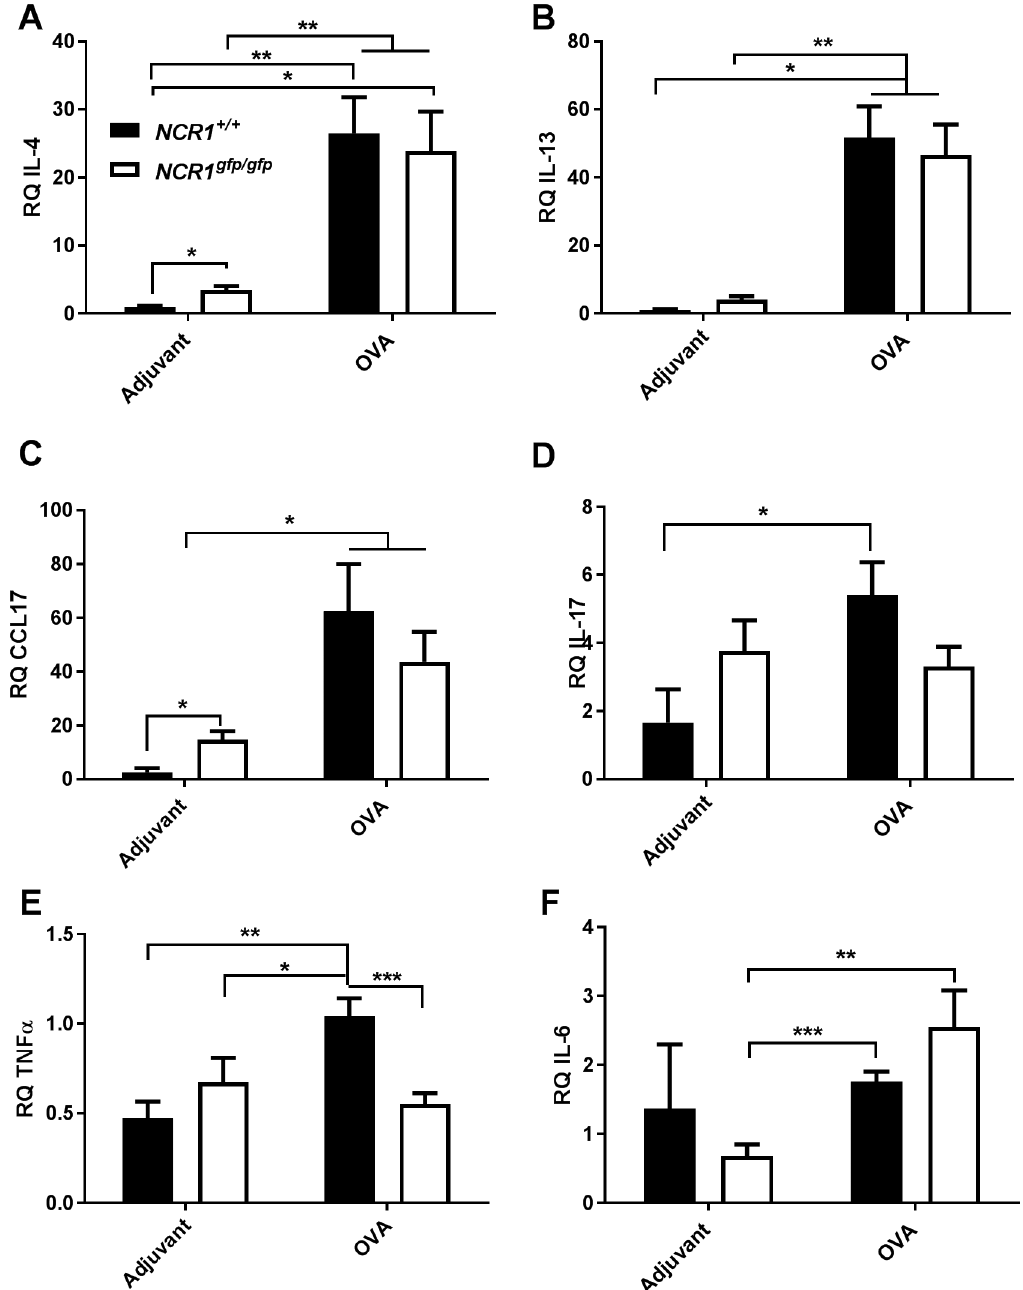
Fig 9. NCR1 involvement in chemokine and Th2, type immune cytokines in response to allergic airway inflammation. NCR1 +/+ and NCR1 gfp/gfp mice were immunized with either OVA or adjuvant as described in Material and Methods, and 24 h following the last challenge the lungs were harvested and taken for RT-PCR. The bar graph represents levels of cytokine mRNA following either adjuvant or OVA immunization. Levels of cytokine mRNA were analyzed by RT-PCR and calibrated to mRNA level of HPRT (n = 3 – 7). (A) IL-4, (B) IL-13, (C) CCL17 (D) IL-17; (E). TNF α ; (F) IL-6. * p < 0.05, ** p < 0.01, *** p < 0.001 compared with the adjuvant immunized NCR1 +/+ group ± SD (two-tailed Student t